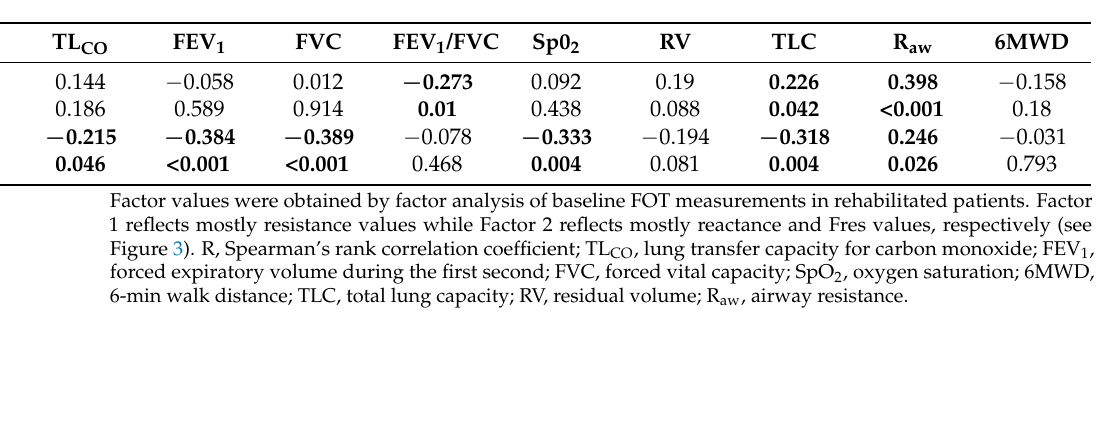
Table 6. Correlations between factors and other lung function and exercise test results.